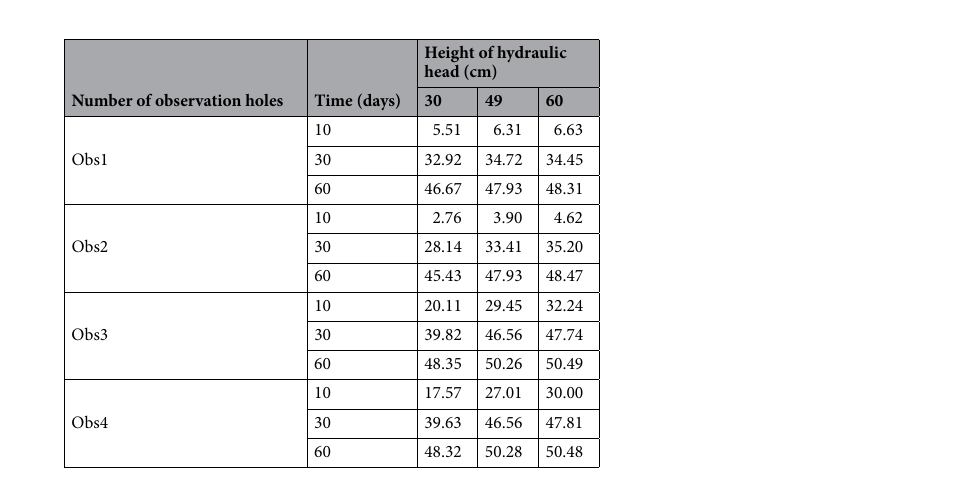
Table 5. Relationship of solute concentration and height of hydraulic